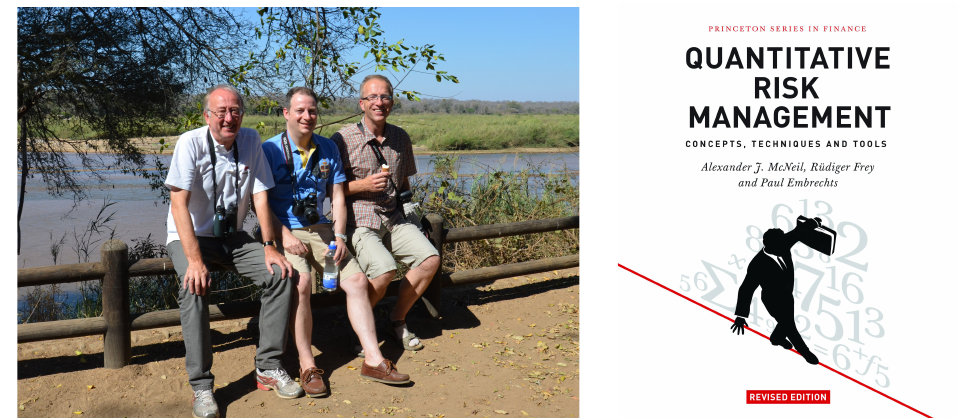
Figure 4: (From left to right:) Paul Embrechts, Alexander McNeil and Rüdiger Frey, the authors of the book Quantitative Risk Management: Concepts, Techniques and Tools - revised edition in 2014 at the Kruger Park (South Africa). The book,